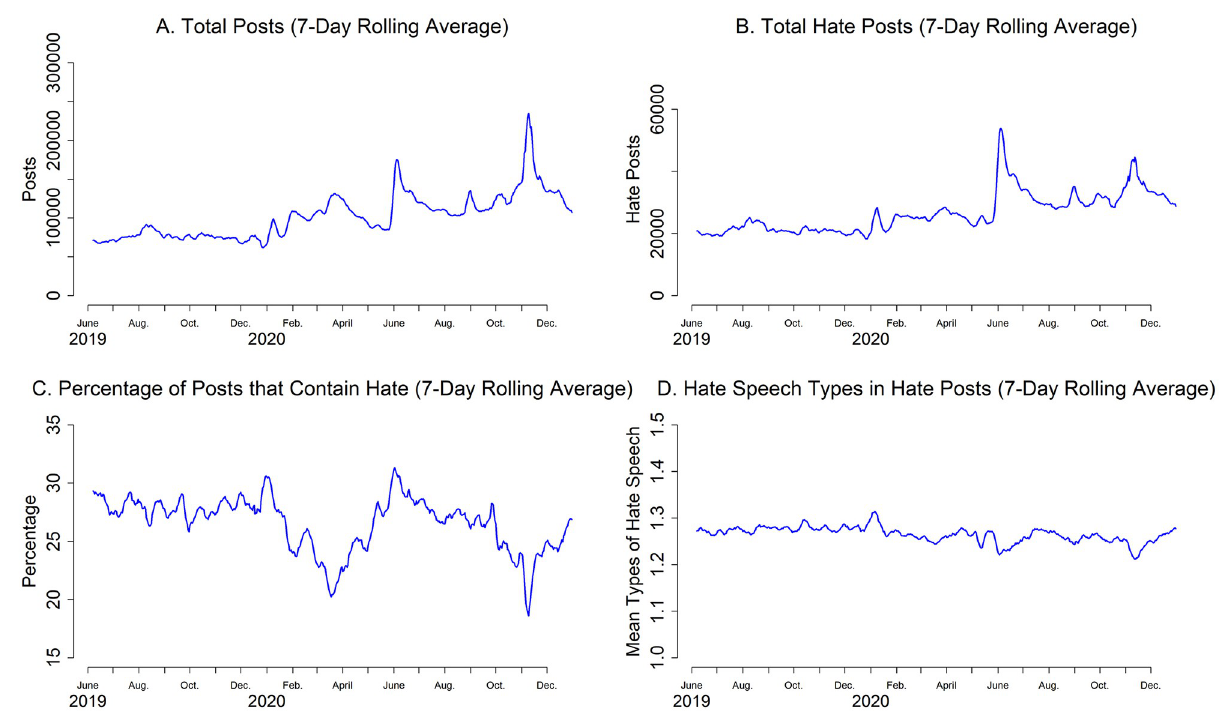
Fig 2. Temporal trends in posts and hate posts. Panel A shows the daily posts in the hate communities we tracked over time. Panel B shows the daily hate posts in these communities over time. Panel C shows the daily percentage of posts that were hate posts over time. Panel D shows the mean number of hate speech types in hate posts over